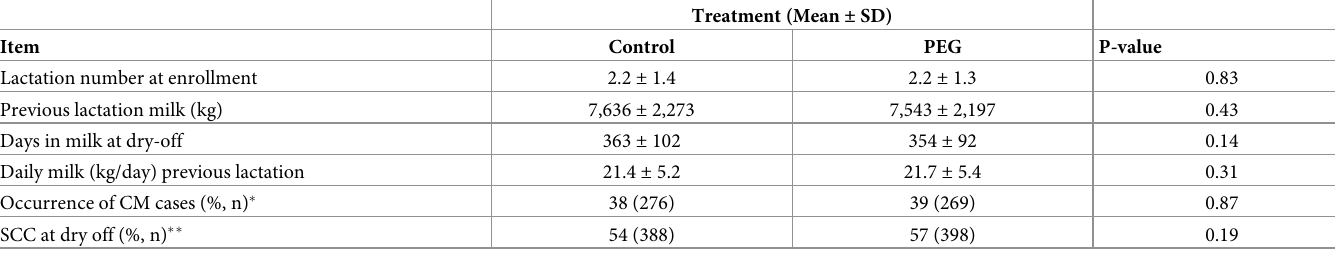
Table 1. Descriptive data from the lactation before enrollment in the study for multiparous cows.